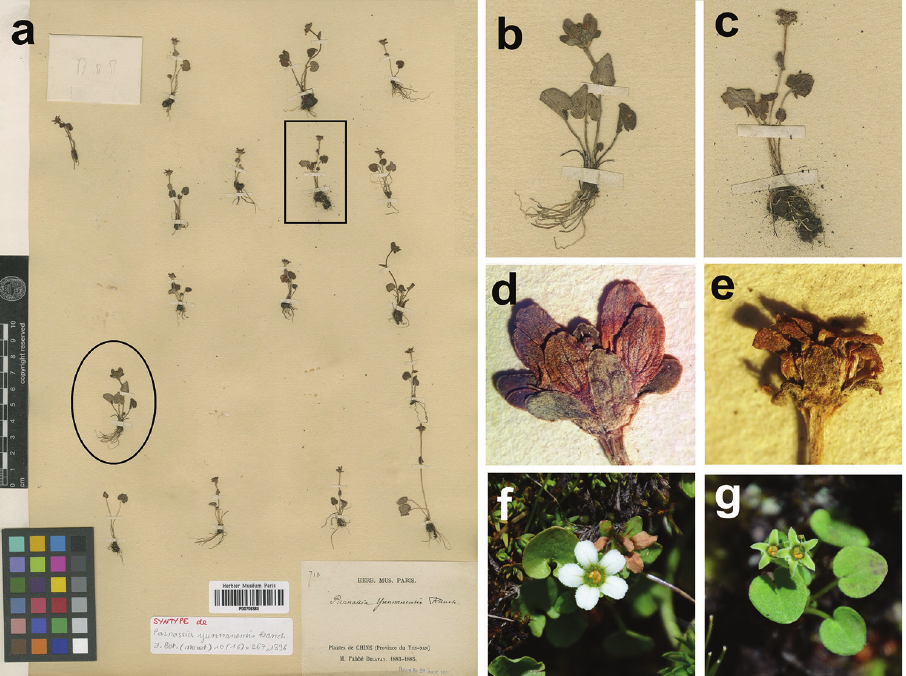
Figure 1. A mixed type specimen of Parnassia yunnanensis . The sheet of Delavay 710 with bar- code P 00709380 ( a ), the individual indicated with a circle and magnified should be determined as P. cacuminum ( b, d ), an individual represents the rest, indicated with a square and magnified ( c, e ), P. cacuminum ( f ) and P. yunnanensis ( g ) in the